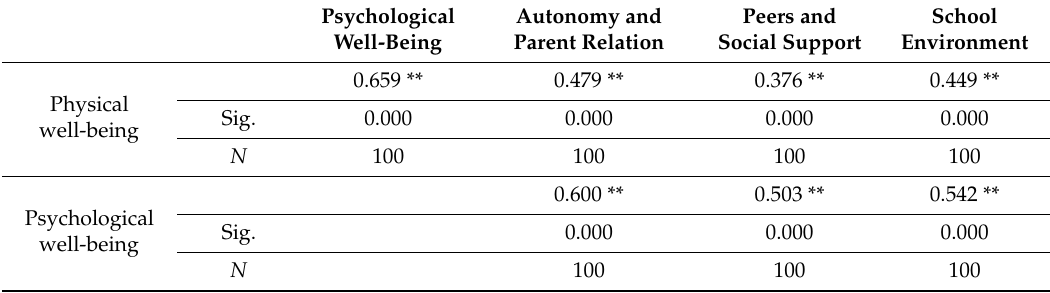
Figure 2. Parent perspective on the quality of life of children with T1DM participating in the study. Pearson’s linear correlation coe ffi cient revealed medium and high correlations ( p < 0.01) between the di ff erent components that ensure quality of life for the investigated subjects (Table 5). Table 5. Pearson’s correlations between the components of quality of life.